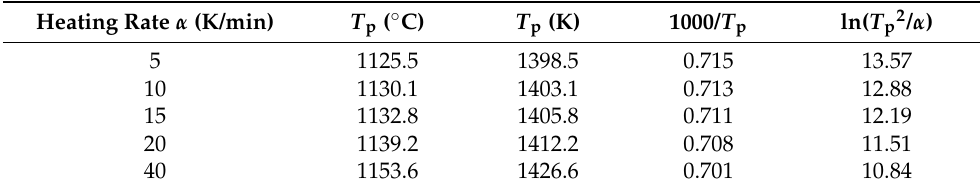
Table 6. Relationship between crystallisation peak temperature T p and heating rate α .